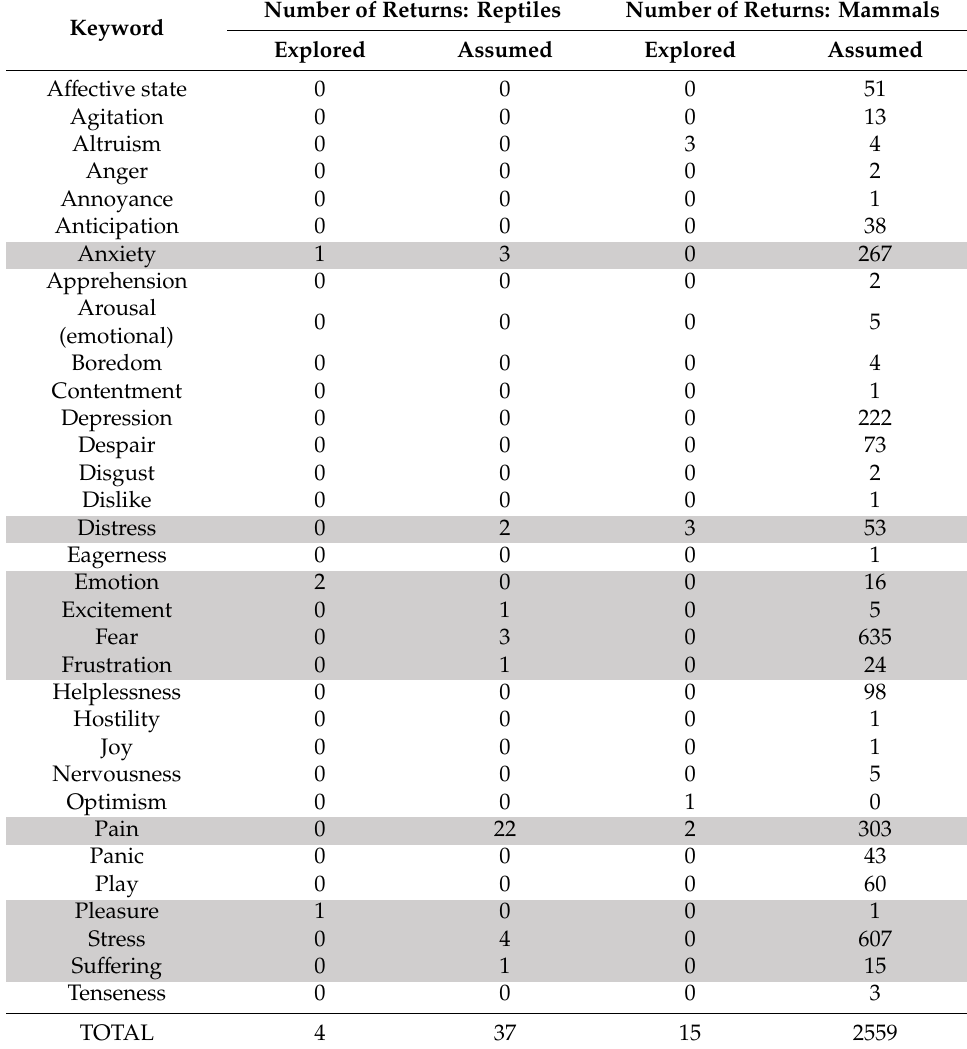
Table 2. The number of returned results for the successful keywords searched for reptiles (current study), and for mammals from a previous review performed on the years 1990–2011 [23]. The entries highlighted in grey were the keywords which returned results for both mammals and